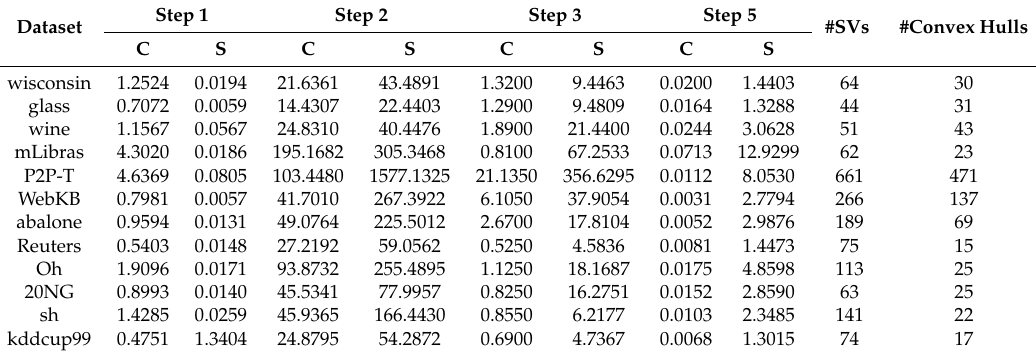
Table 6. Runtime (s) of each step in ED, respectively, consumed by the client (C) and the server (S).